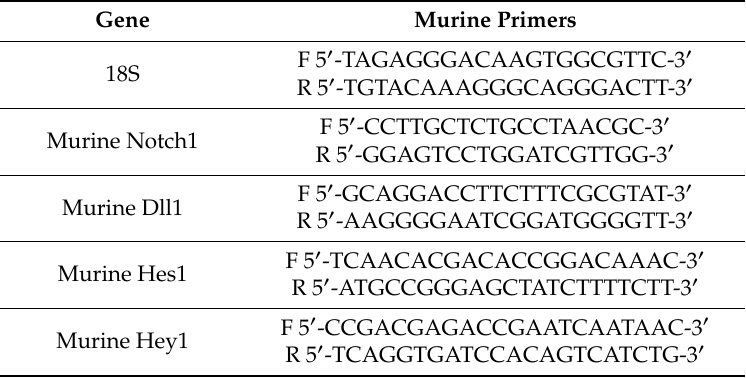
Table 1. Primers employed for mRNA